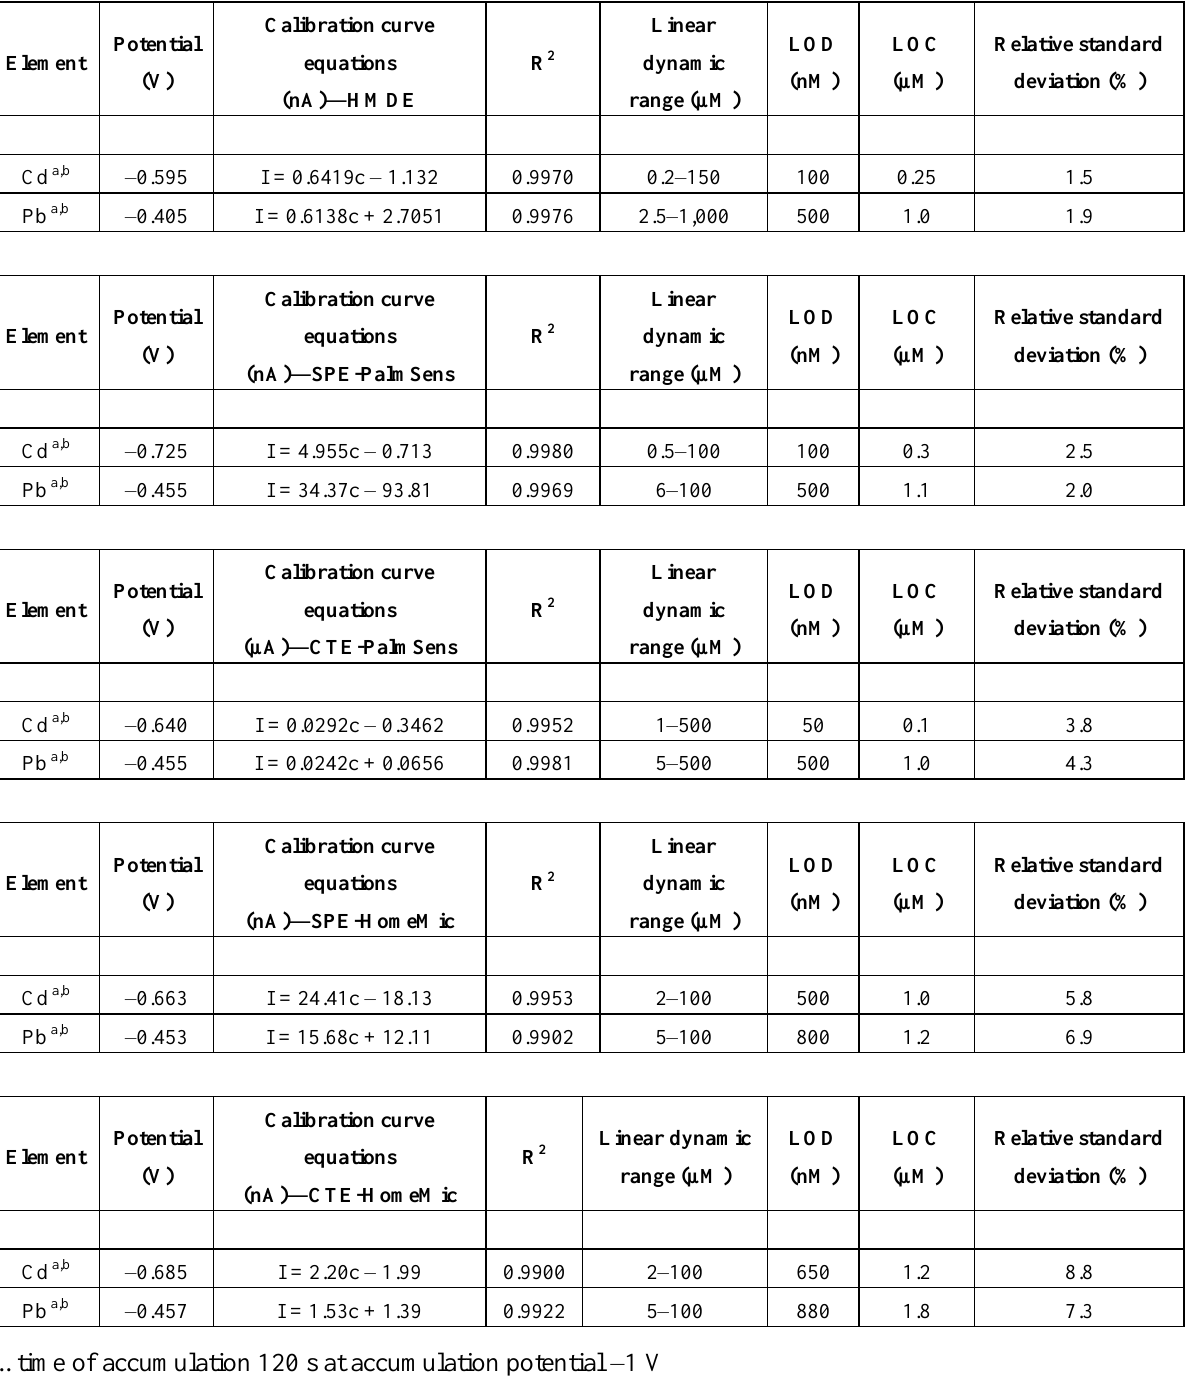
Table 1. Detection of cadmium and lead―analytical